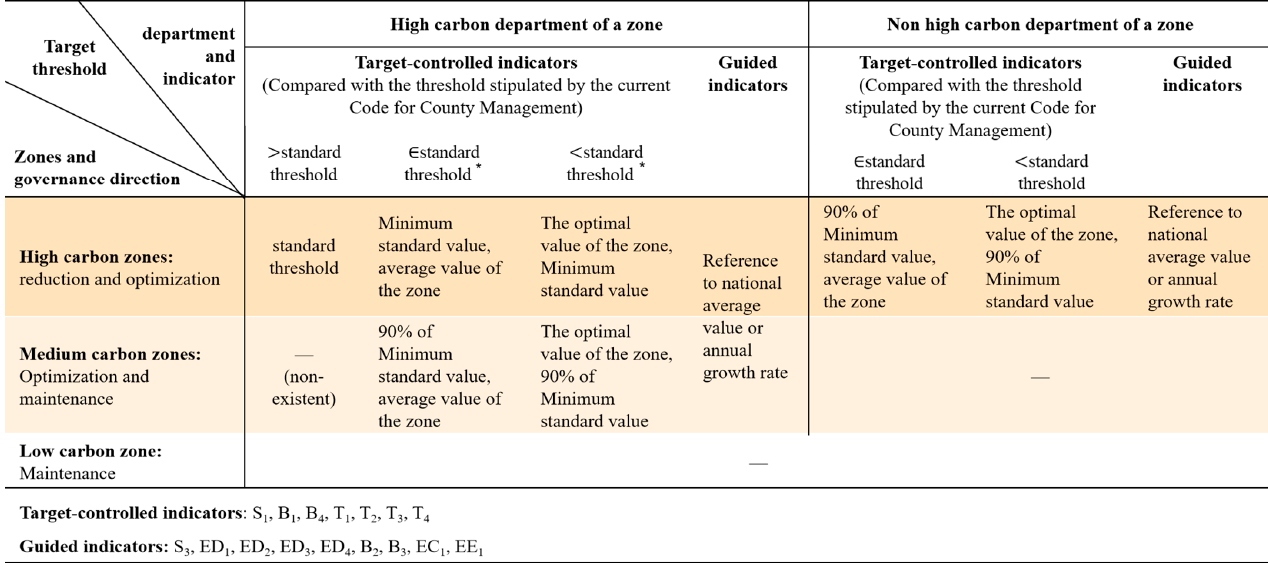
Figure 6. Differentiated carbon emission governance strategies by zone. The superscript of ”*” means that the current governance standard may not be suitable for low-carbon development. In this case, adjustment recommendations should be proposed. Table 5. County low-carbon planning and governance strategies by zone.